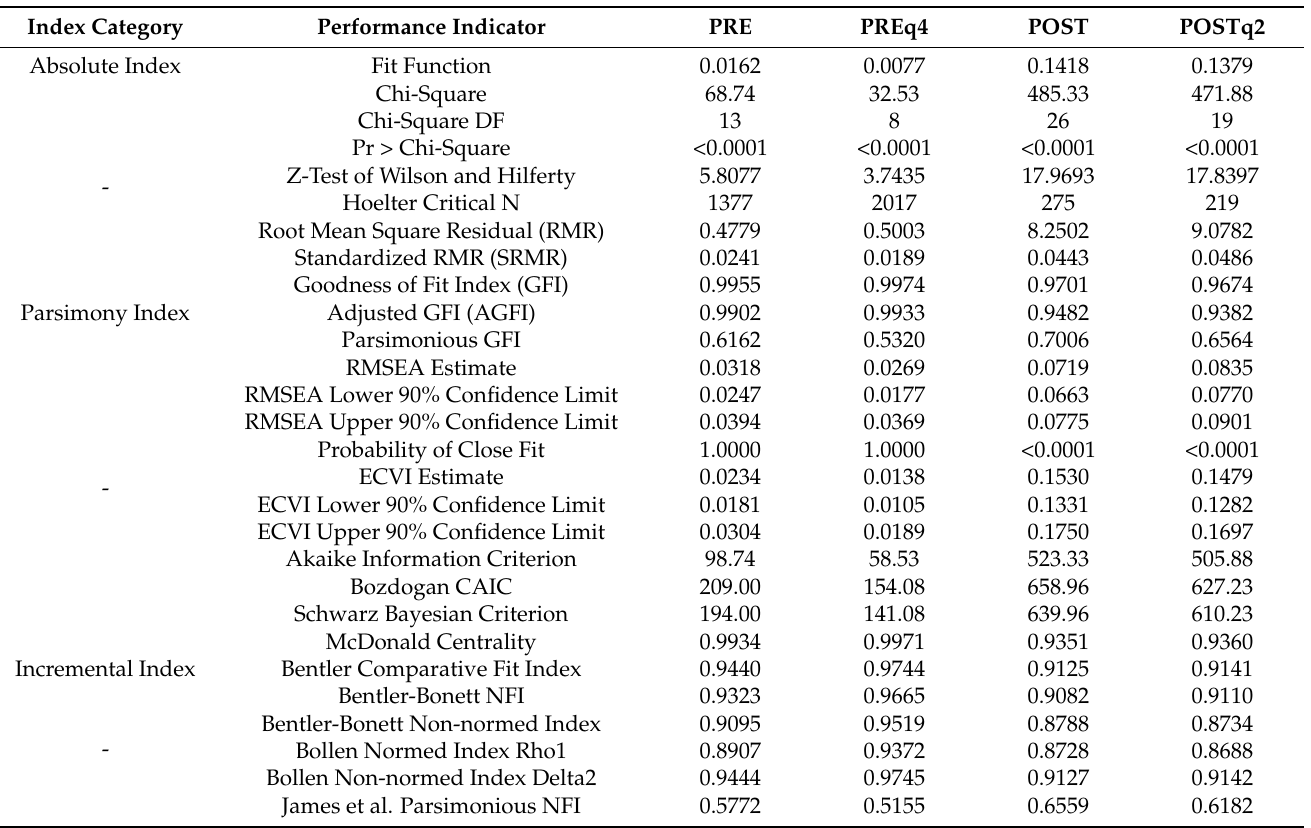
Table 11. Performance indicators of the first-order CFA